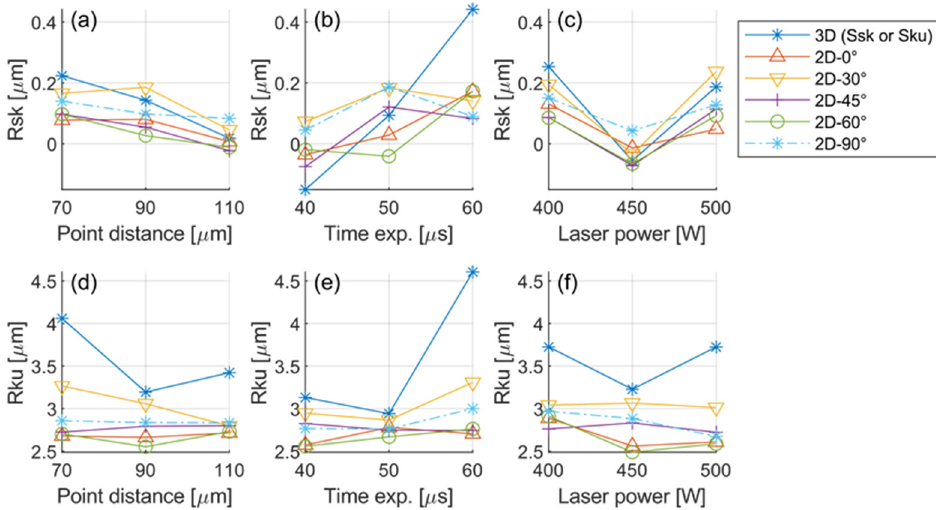
Figure 10. Influence of process parameters on ( a – c ) skewness Rsk and ( d – f ) kurtosis Rku. Effect of ( a , d ) point distance, ( b , e ) time exposure (exp.) and ( c , f ) laser power.